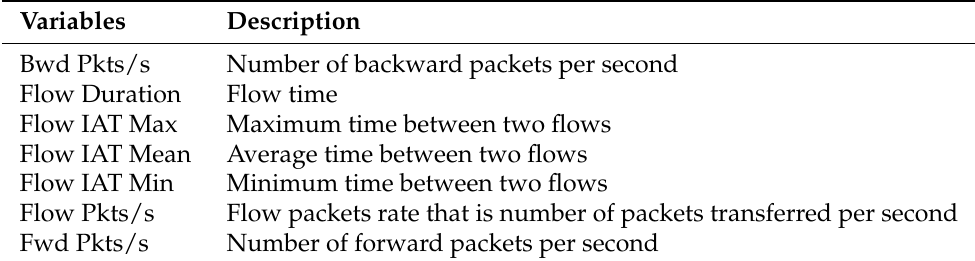
Table 1. Some features of